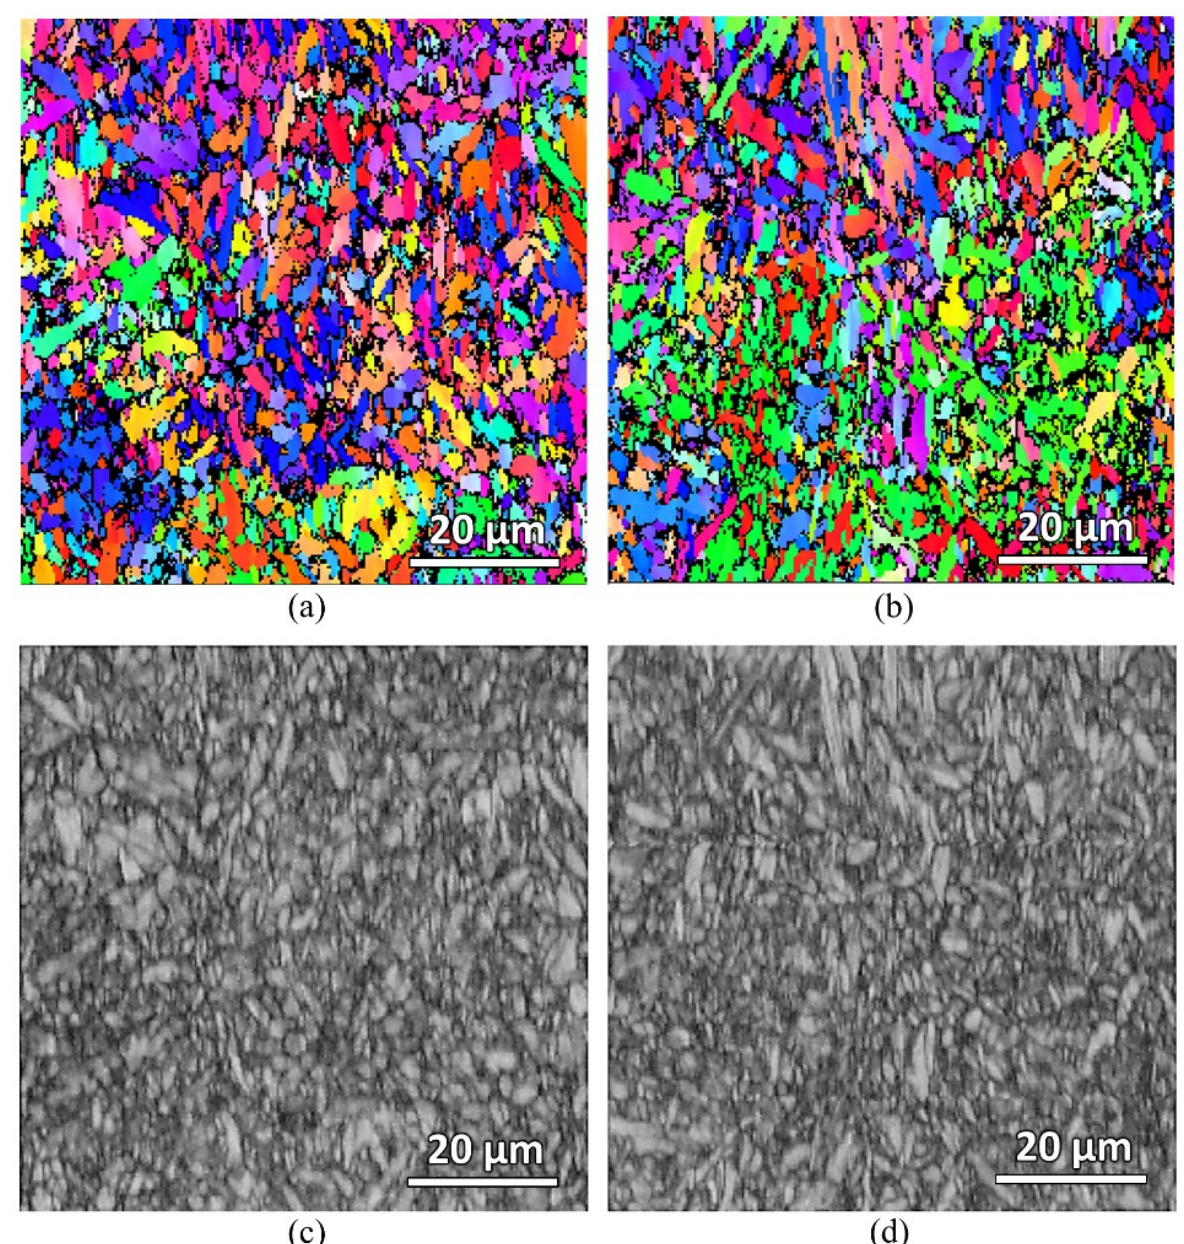
Figure 13. EBSD IPF-Y and band contrast maps of the water-quenched ( a , c ) and air-cooled ( b , d ) furnace heat-treated samples.